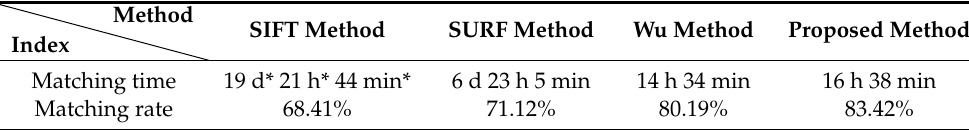
Table 3. Statistical results of the feature matching times and matching rates.